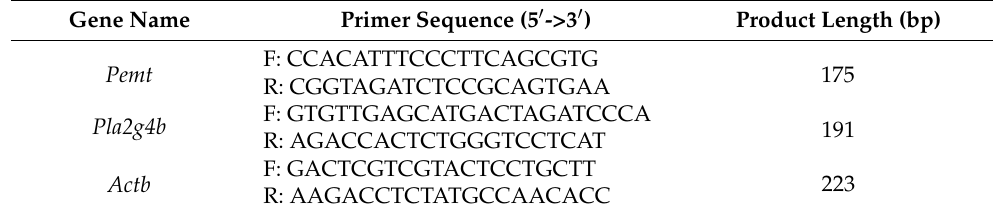
Table 1. The primer used for quantitative real-time PCR amplification.